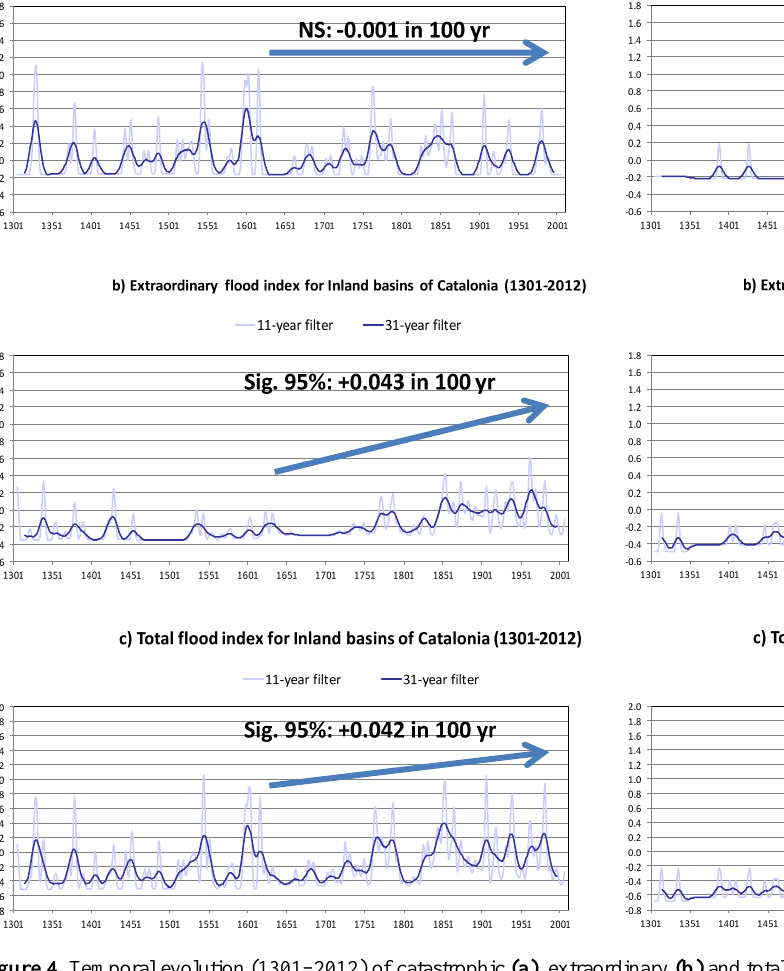
Figure 4. Temporal evolution (1301–2012) of catastrophic (a) , extraordinary (b) and total (c) flood index series for inland (Ebro, Segre and Ter basins; left panels) and coastal basins (Llobregat mouth, Barcelona County and Maresme basins; right panels). The result of applying a trend analysis for each series is also